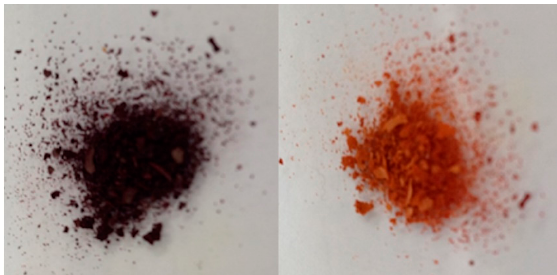
Figure 9. Colour change of fac -[Fe(4-ima-Bp) 3 ](ClO 4 ) 2 ⋅ 3MeOH 1 heating from 298 K ( left ) to 423 K ( right ).